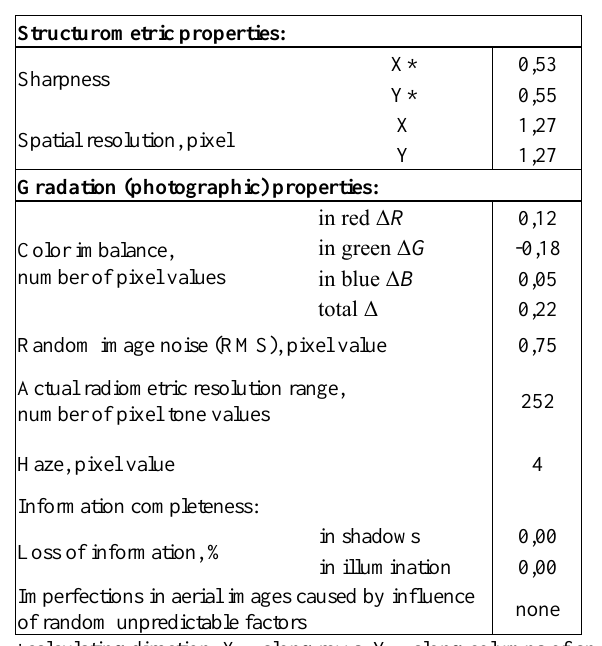
Figure 18. Aerial image, obtained by camera Sony RX, installed on light UAV and graphs of the color balance for each of the color component, the image has poor visual quality